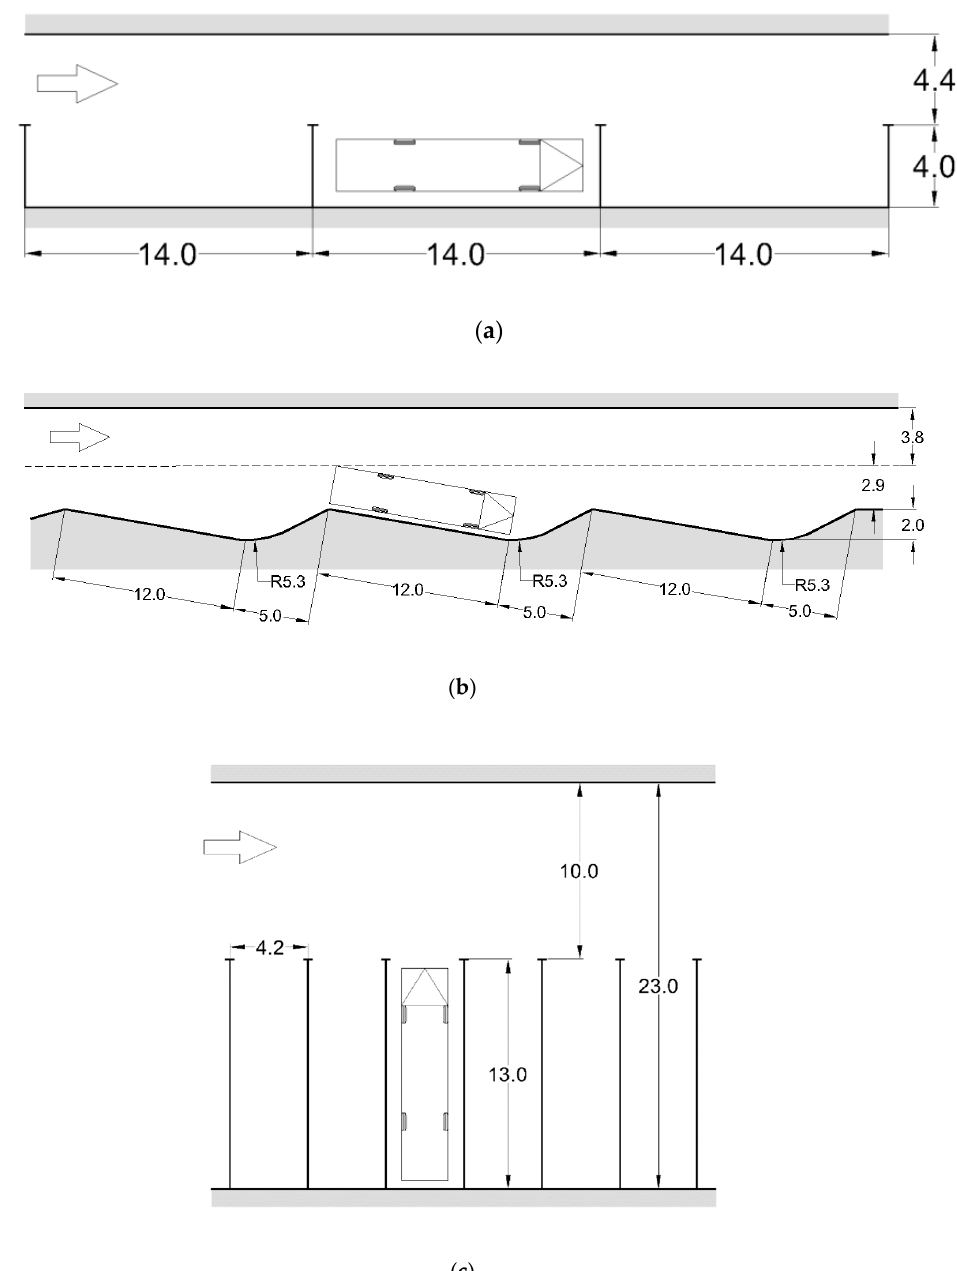
Figure 13. The scheme of parking spaces for city buses: ( a ) when parallel; ( b ) saw tooth; ( c ) a perpendicular placement in relation to the driveway or manoeuvring zone.